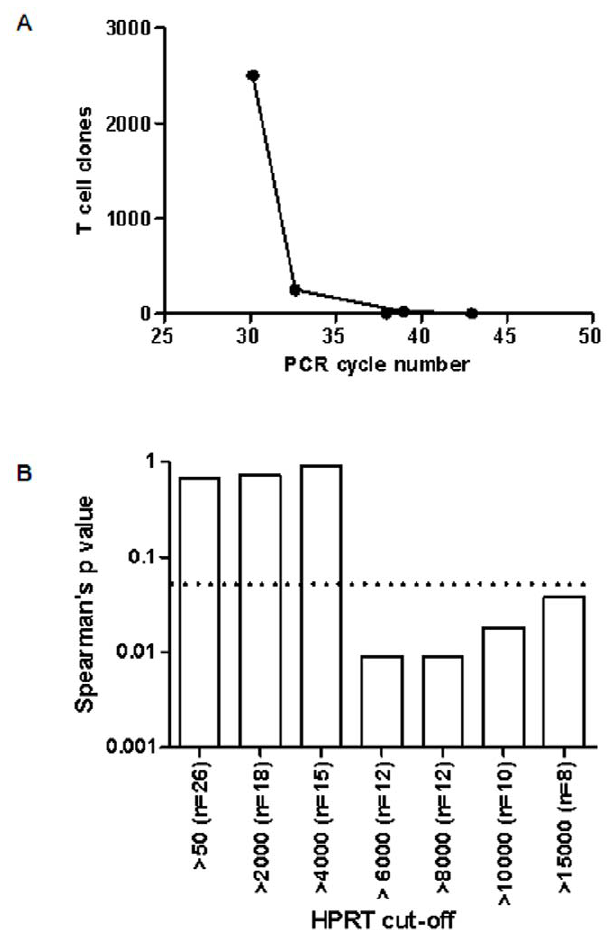
Figure 3. Correlation of qPCR with the IFN- c ELISPOT assay is dependent on the frequency of antigen specific T cells present and the quantity of viable cells tested. A) The qPCR detection of IFN- c secreted by a known number’s of mouse CD8 T cell clone’s. The detection limit is . 25 and , 250 T cell clones/10 6 splenocytes. B) Spearman’s correlation of TRAP peptide stimulated IFN- c measured by qPCR and ELISPOT improves as the cut-off for HPRT copy number increases. The dashed line indicates a p value of 0.05.